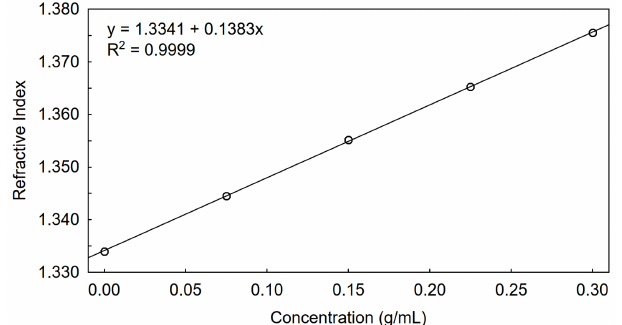
Figure 1. Determination of dn / dc for sucrose in 50 mM phosphate bu ff er (pH 8.0) with 100 mM urea using Abbe